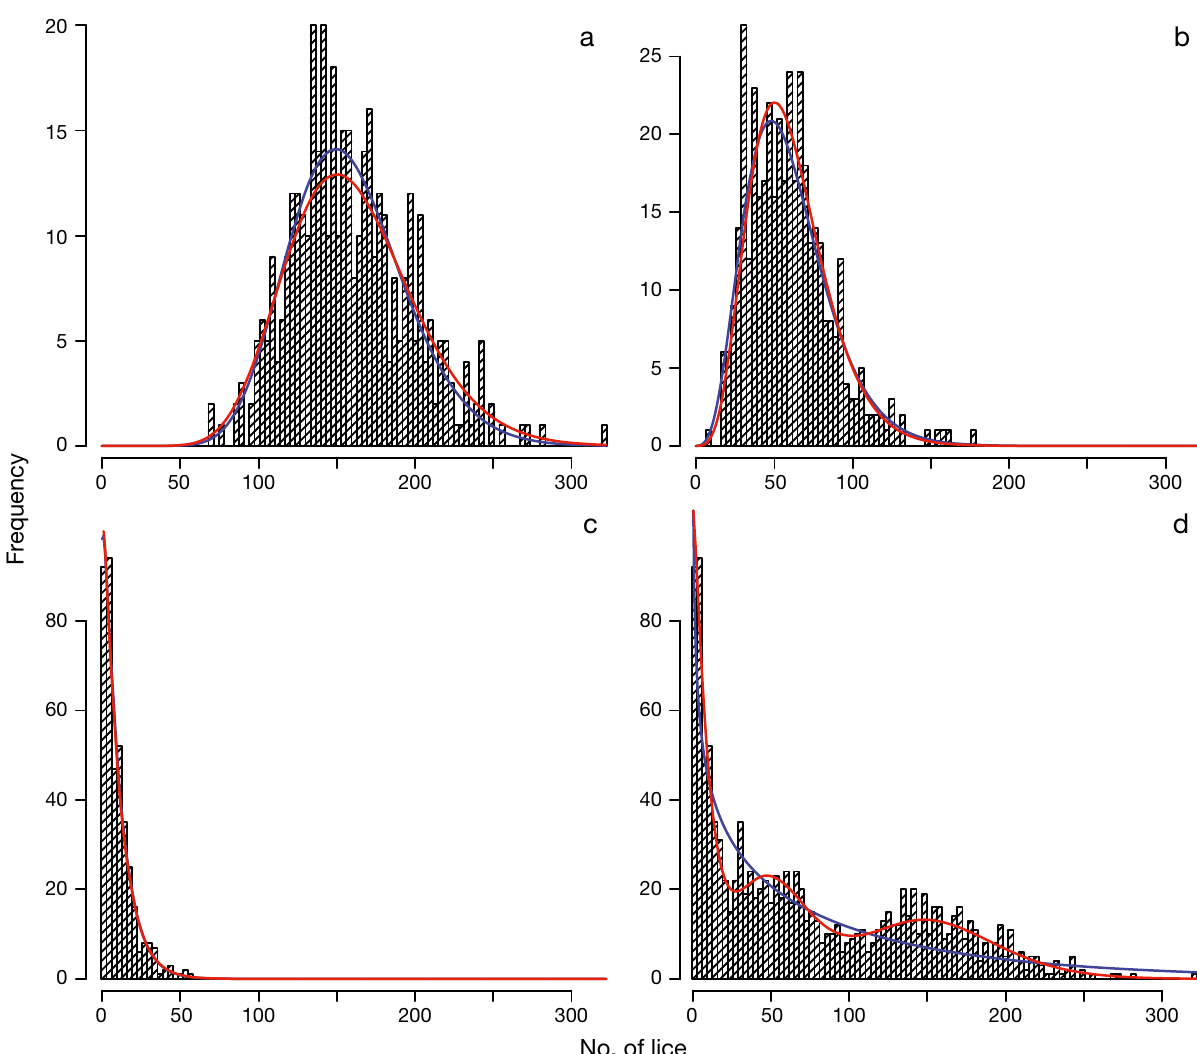
Fig. 3. Accumulated lice infestation distributions in Week 3 for the 3 temporal ocean groups: (a) all 3 weeks; (b) Weeks 2 and 3; (c) Week 3 only. (d) The mixture distribution after Week 3 if the groups are assumed to be of equal size. Red lines: theoretical distribution from which we simulated; blue lines: fitted negative binomial